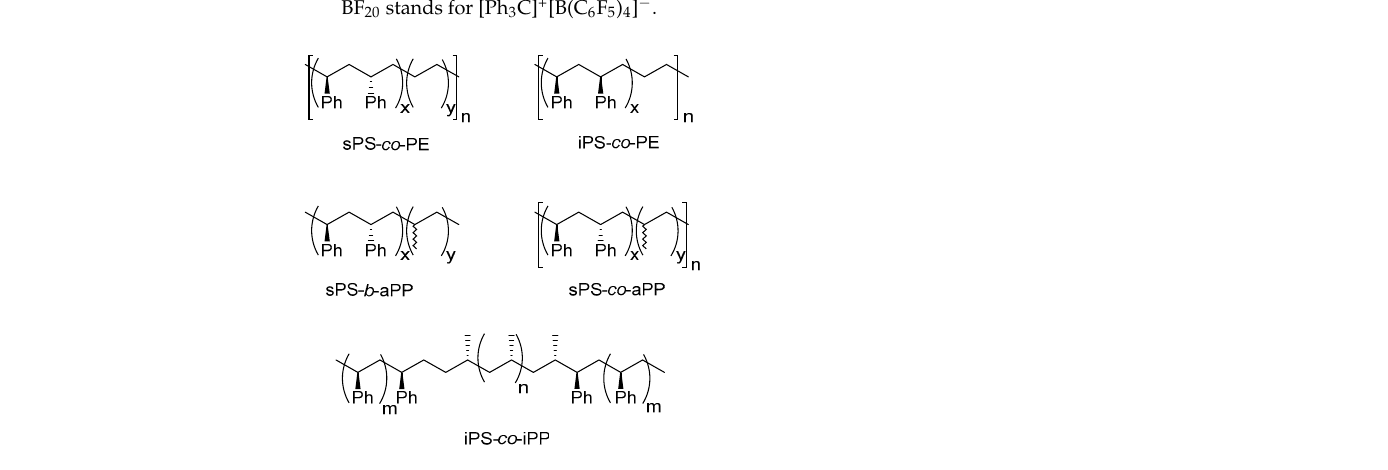
Figure 3. Structures of stereoregular styrene-ethylene and styrene-propylene copolymers.